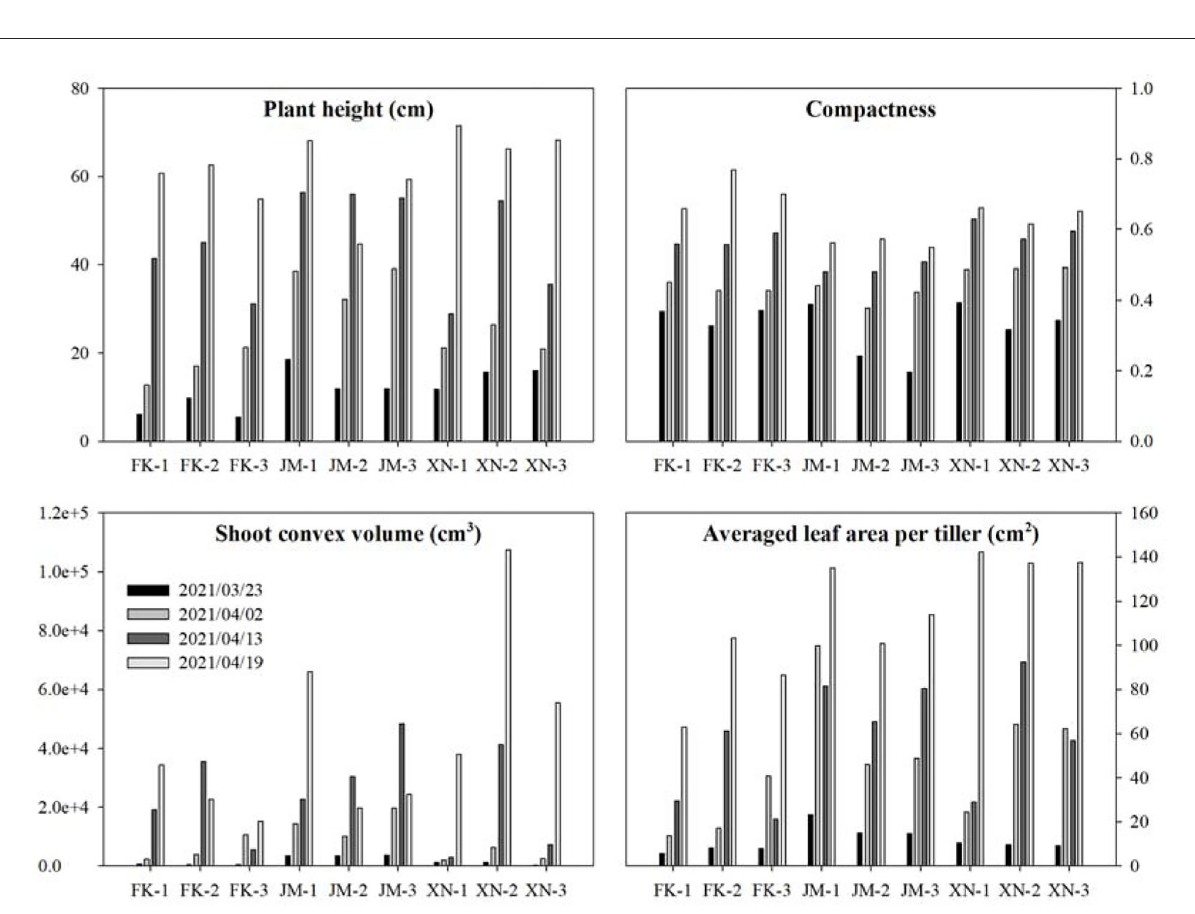
FIGURE13 Estimated phenotypes of three wheat cultivars at four growth stages. Each cultivar had three samples. The estimated phenotypes include plant height, compactness, shoot convex volume, and averaged leaf area per tiller.